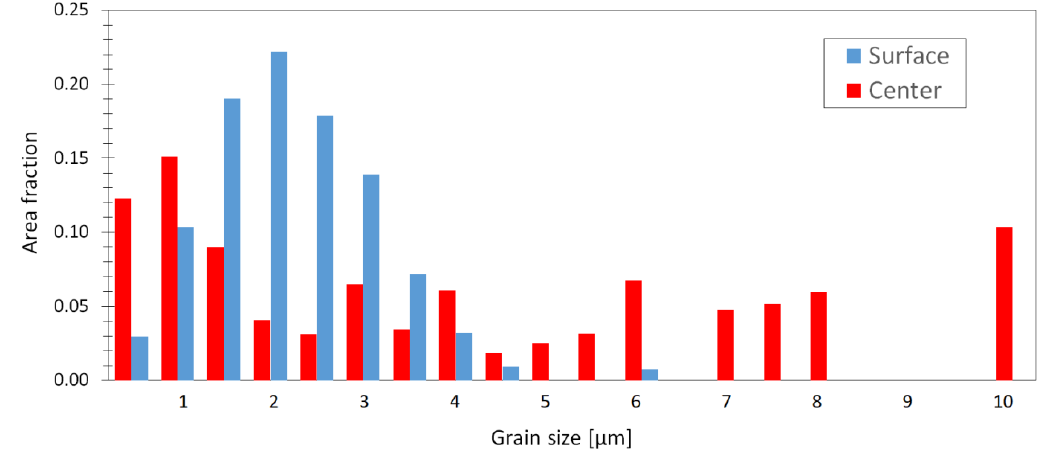
Figure 14. Grain size distributions in the ECS material measured in the tangential sections (TR plane).